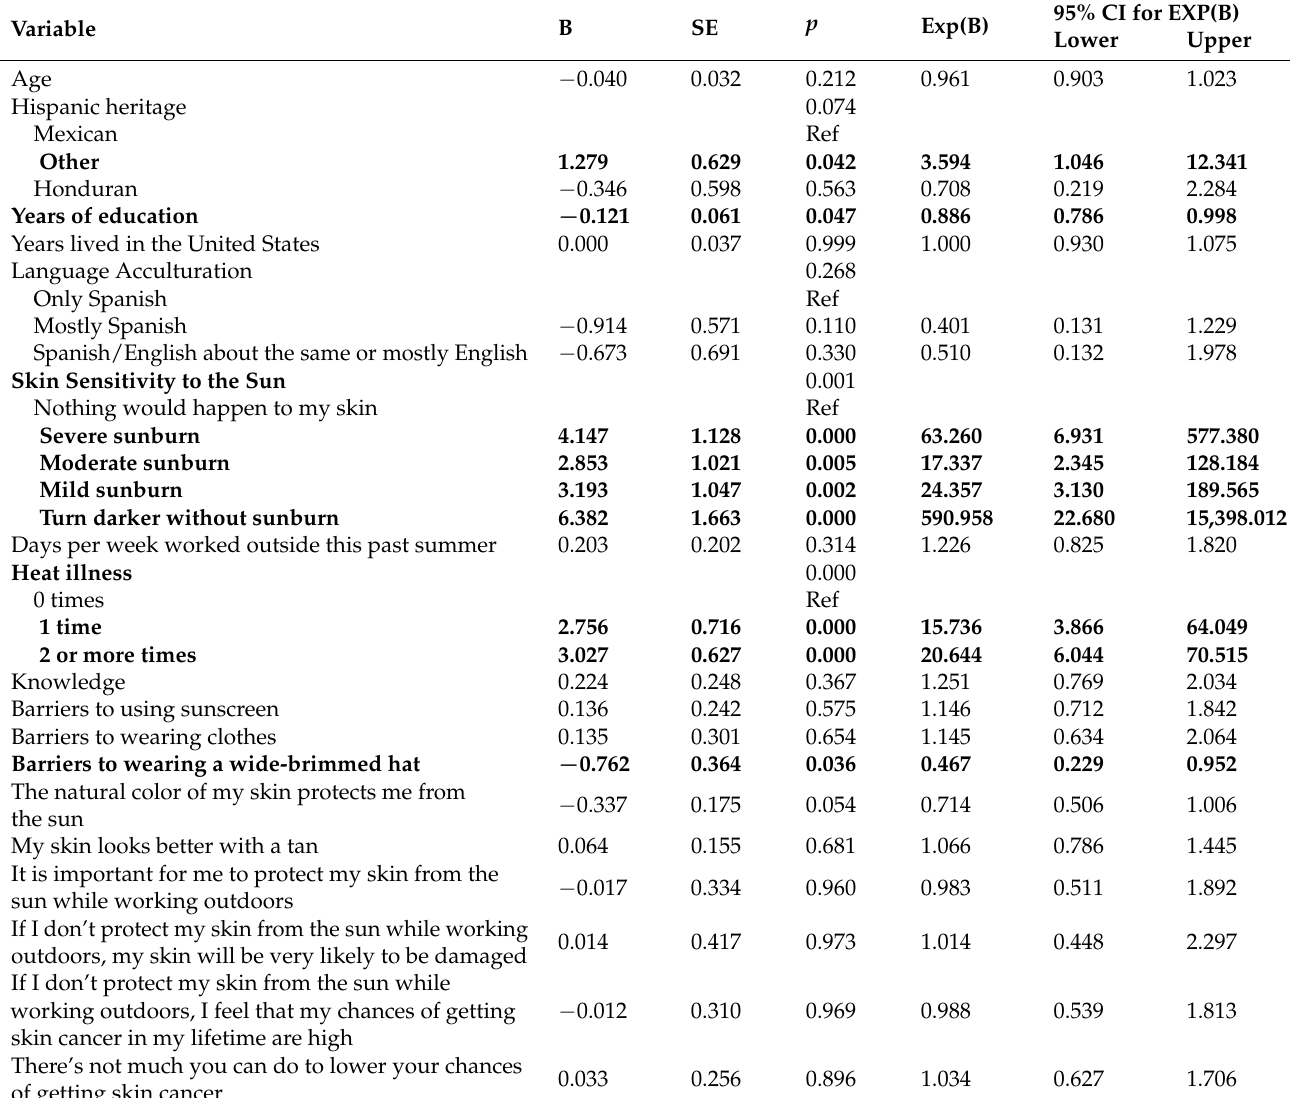
Table 6. Logistic regression of the correlates of